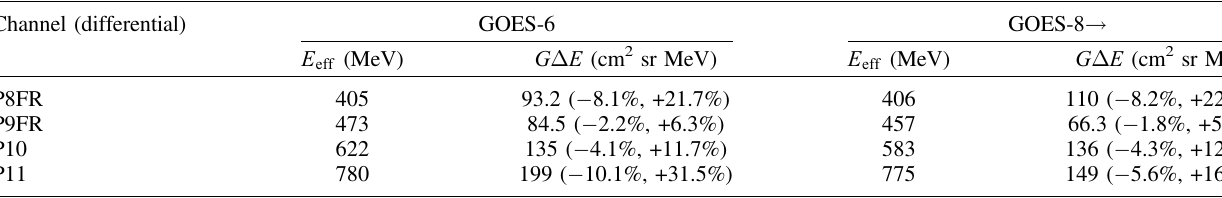
Table A.1. Results of bow-tie analysis for differential channels. Channel (differential) GOES-6